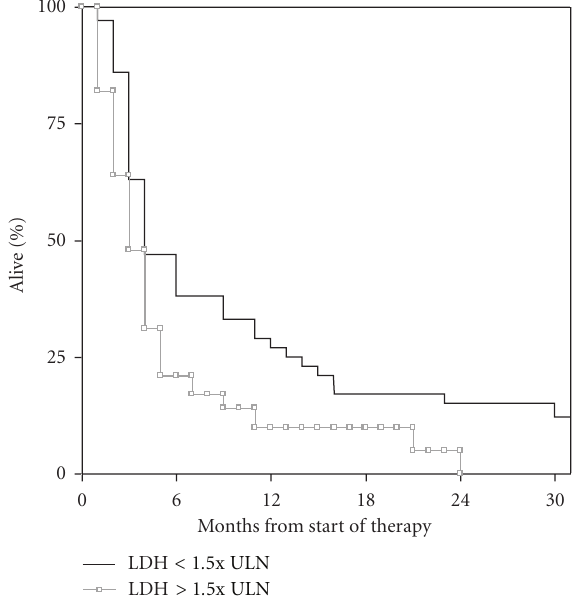
Figure 1: Kaplan-Meier curves for overall survival: normal LDH ( n = 41) versus elevated LDH ( n = 59); P = 0 . 037. Figure 2: Kaplan-Meier curves for overall survival: LDH less than 1.5x upper limit of normal ( n = 65) versus LDH higher than 1.5x upper limit of normal ( n = 35); P = 0 . 013.